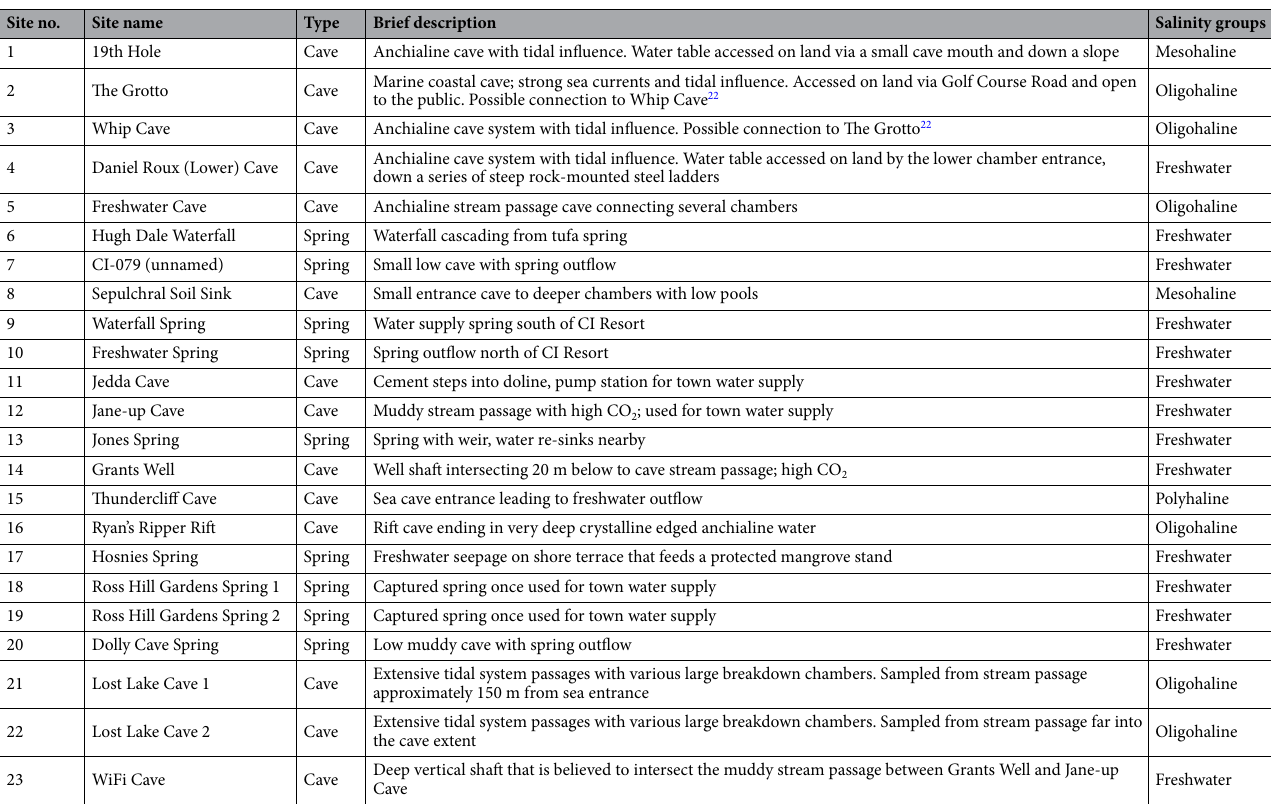
Table 1. eDNA site information on Christmas Island. Type refers to whether samples at each respective site were taken from within a cave system or at a surface spring. Salinity classifications for each site were assigned based on salinity readings at the time of sample collection (see Table S1 for full environmental parameter data and CI cave index numbering).